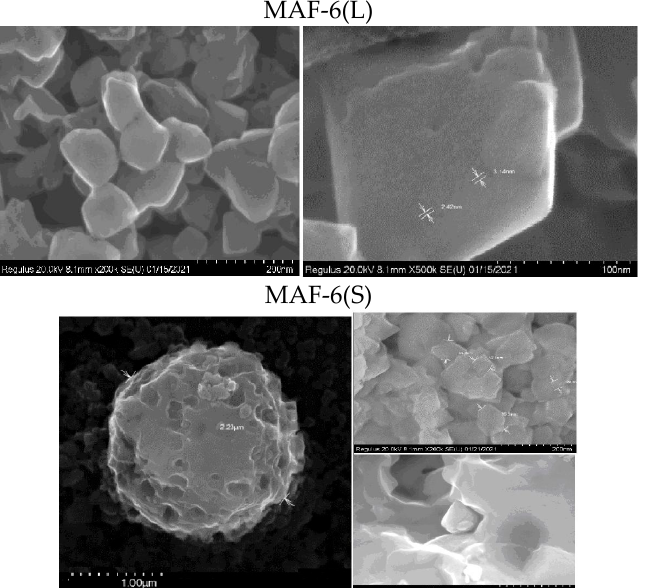
Figure 7. SEM images of MAF-6 samples with different particle size after catalytic test in reaction of propylene oxide with CO 2.